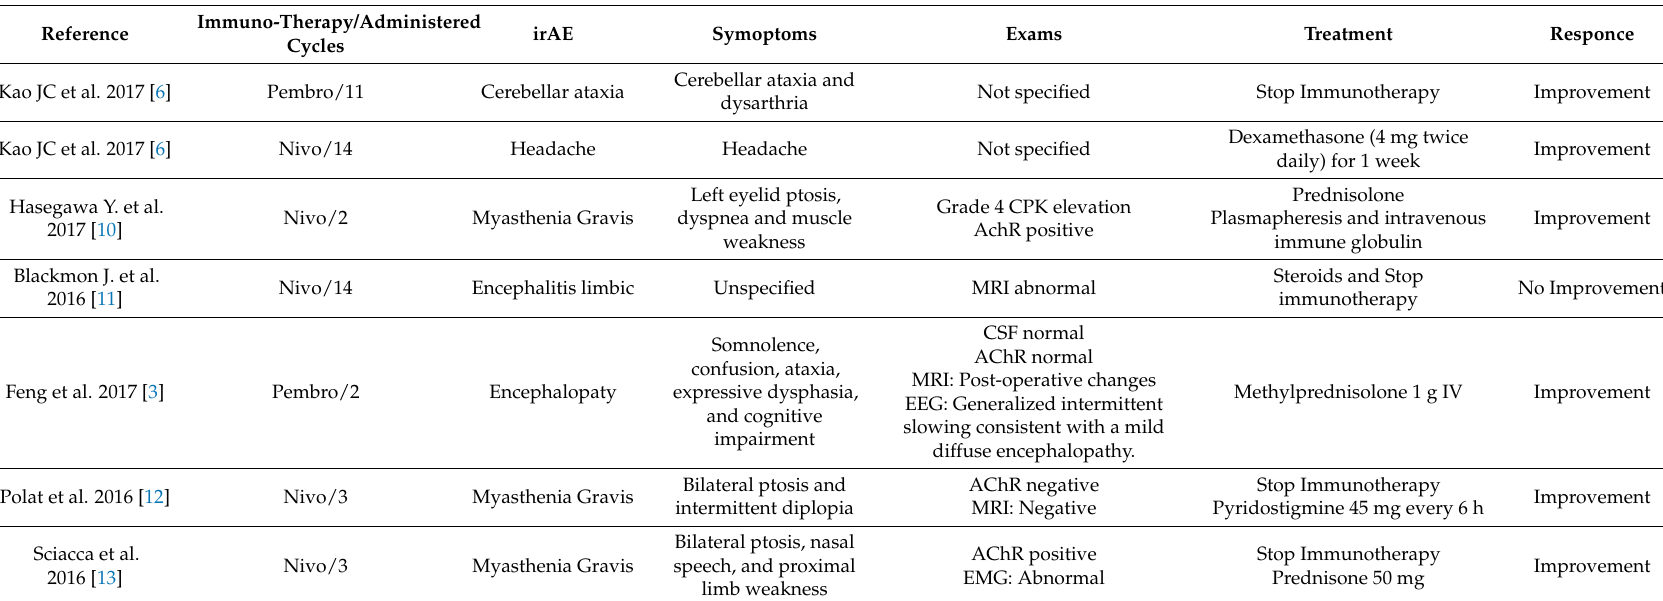
Table 1. Selection of reported cases of neurological immune-related Adverse Events (irAEs) due to anti PD-1